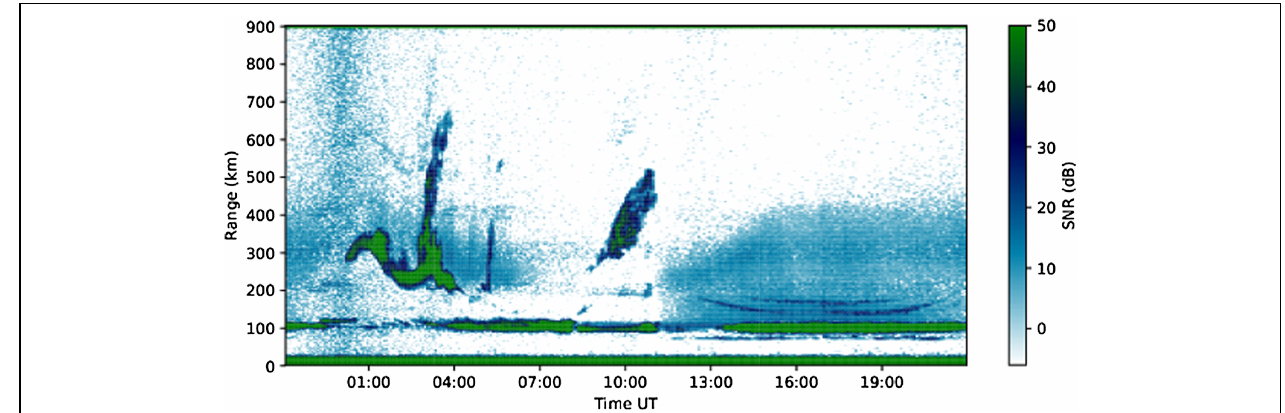
FIGURE 1 | Range time intensity plot for September 14, 2010, showing backscatter signal-to-noise ratio versus altitude and time. Note that UT = LT + 5 h. Cyan hues mainly represent incoherent scatter whereas blue and green hues represent coherent scatter (see text).